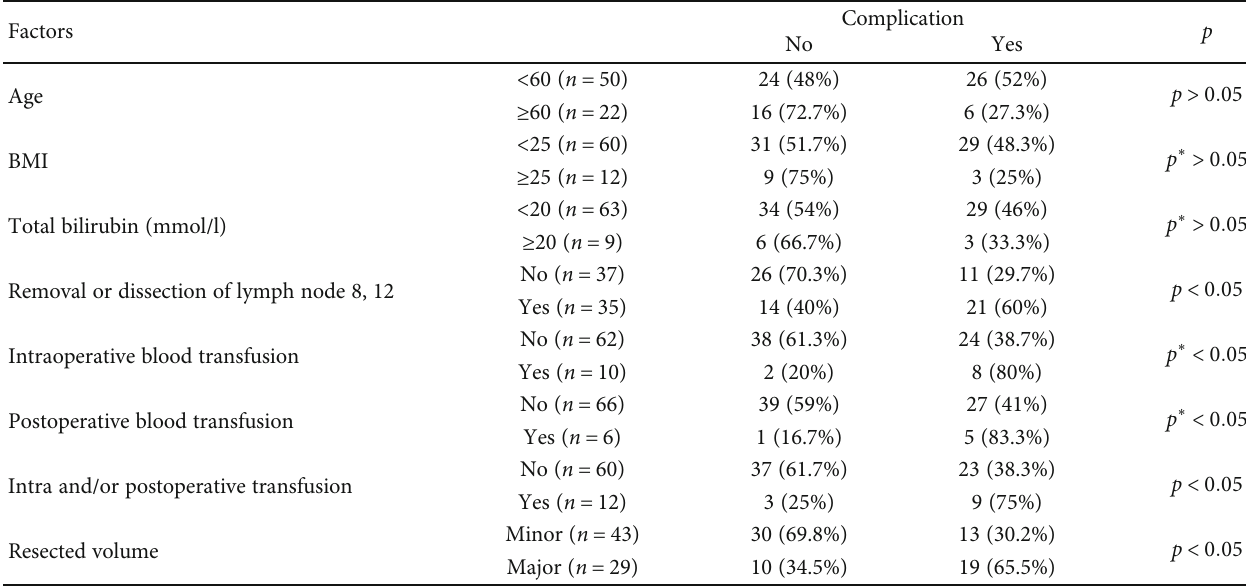
Table 6: Factors a ff ect early postoperative